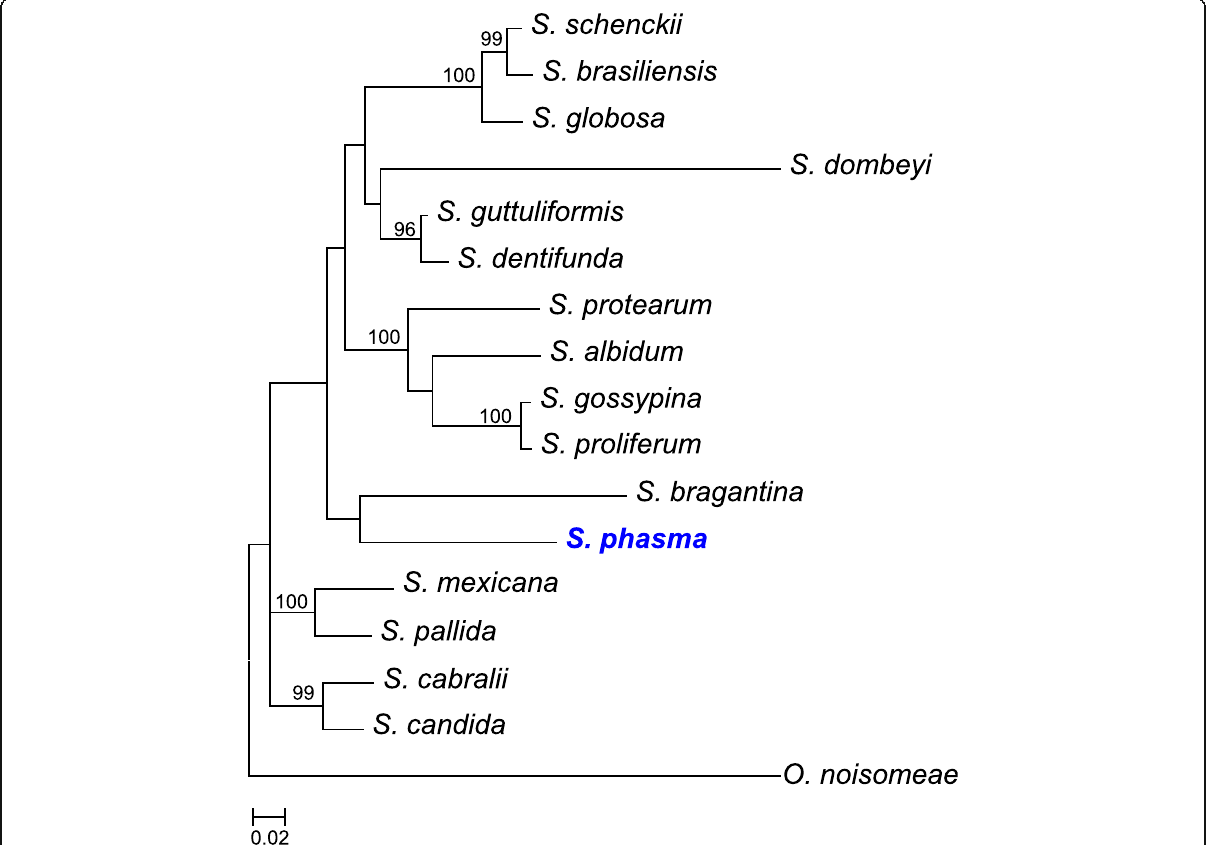
Fig. 3 Phylogenetic tree depicting the relationship between genome sequenced S. phasma (in blue and bold) and related species in genus Sporothrix . The tree was constructed from LSU, ITS, BT and CAL gene regions using RaxML. Bootstrap support (1000 replicates) are indicated at the